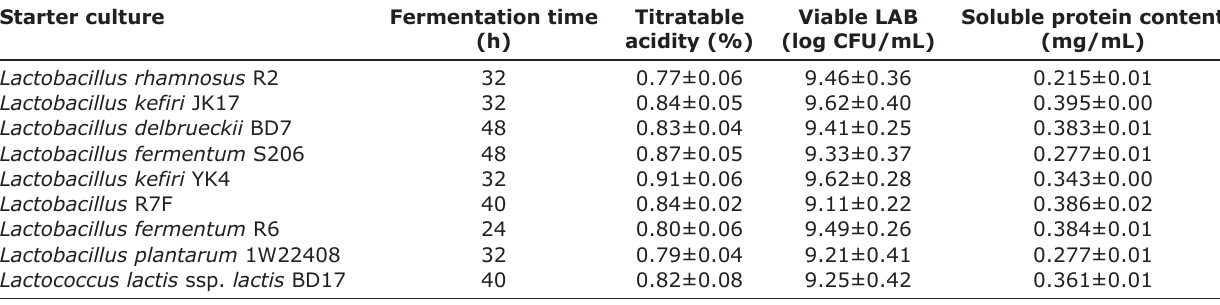
Table-1: Fermentation time, titratable acidity, viable count of LAB, and soluble protein content in fermented milk after pH 4.6 were reached. Starter